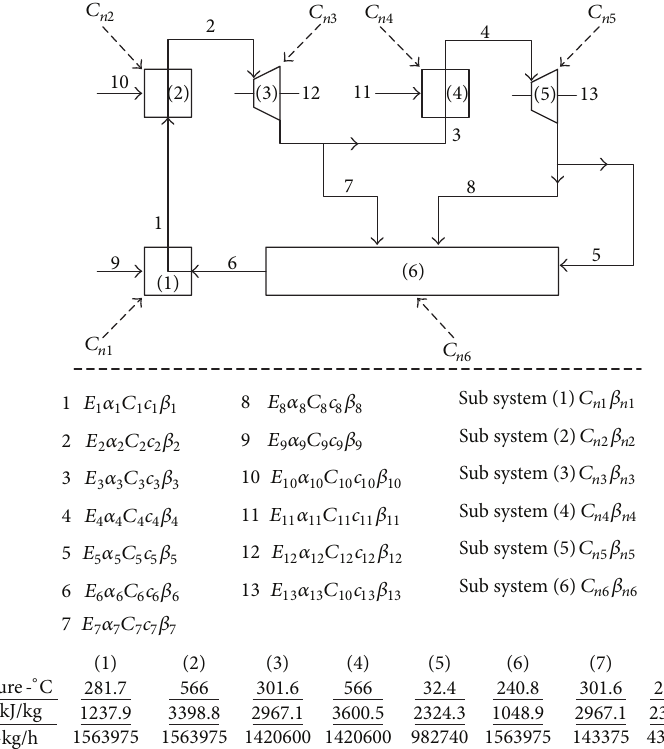
Figure 3: Schematic representation of solar aided coal-fired power generation